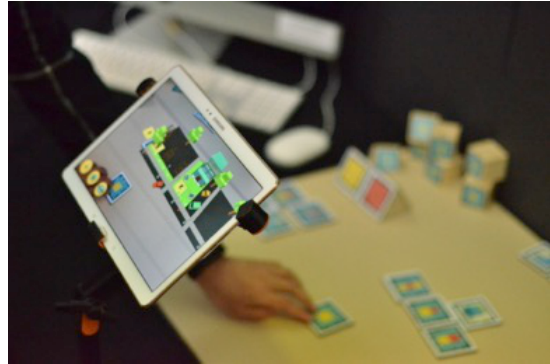
Figure 6. 2015 MADA exhibition test According to outcomes of two users’ tests, an improved tutorial function is designed in another project, which is an AR educational training approach for autistic children. As shown in Figure 7, the design of tangible components contains different shapes cards, which can assemble together as well as puzzle pieces. And same functional cards have their special colours in order to help children to identify various functions of cards. An animated tutorial page is provided to users. The system will show different function cards on the screen one by one, and users should choose the correct cards shown on screen in order to proceed with the tutorial. The new tutorial function was tested with same participants. All the subjects indicated that the new tutorial method was a huge improvement compared to the previous one, and the average score of instruction (for children) increased from 4.6 to 7.5.